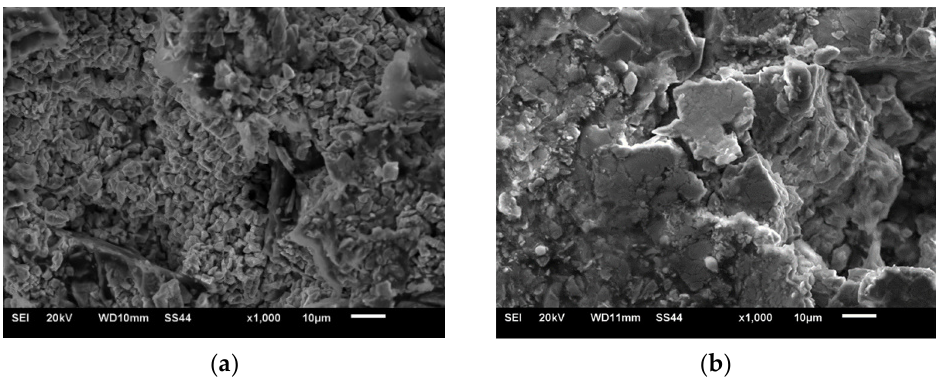
Figure 11. SEM images of LaNi 4.7 Ge 0.3 ( a ) and LaNi 4.4 Ge 0.6 ( b ) composite electrodes after cycling stability test (100 charge/discharge cycles at 500 mA g −1 ).